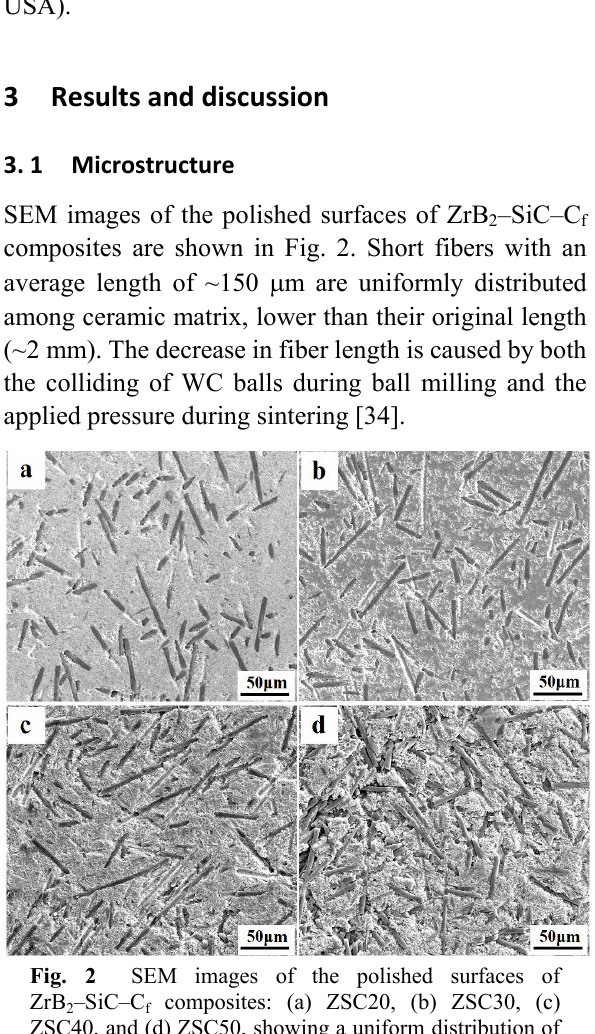
Fig. 1 SEM images of (a) the starting ZrB 2 powders (inset is the X-ray diffraction pattern) and (b) the mixed ZrB 2 –20 vol% SiC–30 vol% C f powders, showing the powders with an average particle size of 150 nm and the uniform distribution of carbon fibers in the ceramic powders.